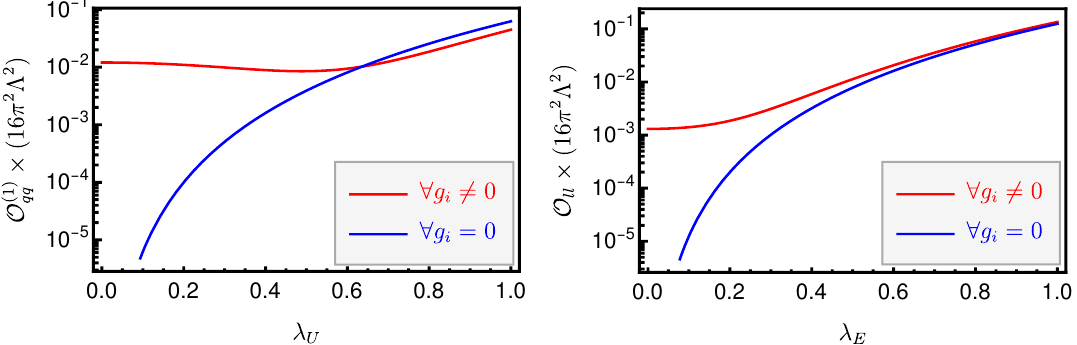
Figure 10. The coefficients for the operators O (1) qq (left) and O ll as a function of the new Yukawa coupling λ and λ respectively. In each case we multiply the coefficient by a factor 16 π 2 Λ 2 , U E where Λ is either M or M , common to all one-loop generated operators. The blue lines set U E all SM couplings to zero arbitrarily while the red lines show the calculation for g discussion see